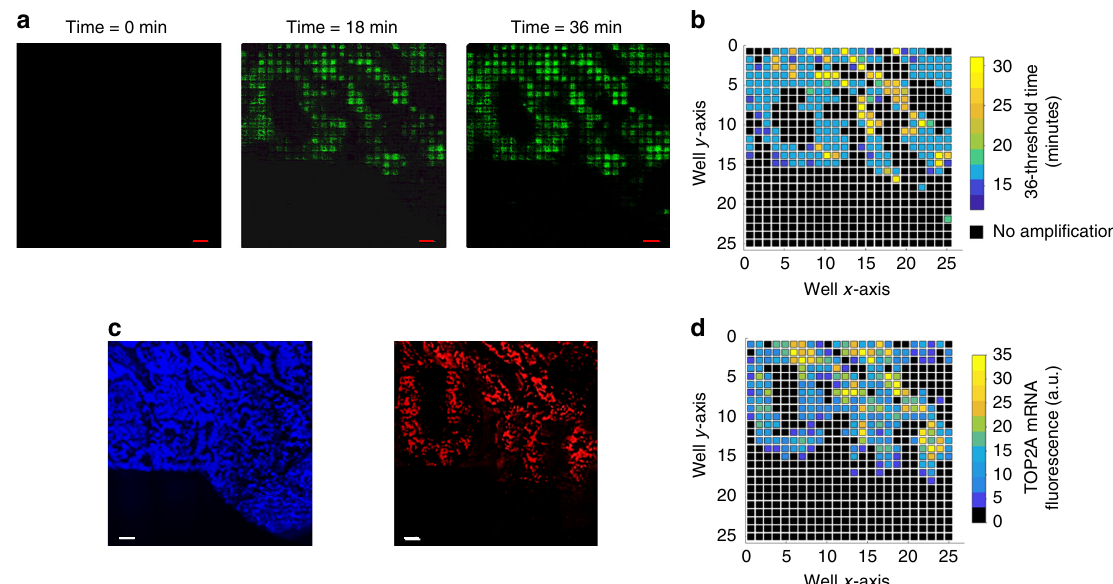
Fig. 6 On-chip RT-LAMP with mRNA FISH on serial sections. a Baseline-subtracted fl uorescence images of real-time RT-LAMP with tissue on chip at three different time points showing the increase in fl uorescence over time (scale bar: 200 µ m). b Spatial threshold analysis showing the spatially mapped threshold times. No ampli fi cation was observed till 36 min. c DAPI (blue) and TOP2A mRNA FISH (red) images of the consecutive section showing spatial heterogeneity in TOP2A mRNA expression (scale bar: 200 µ m). d Pixelated intensity map of mRNA FISH fl uorescence. The spatial pattern of TOP2A expression is similar between the two assay types. For b , d , each pixel is 100 µ m × 100 µ